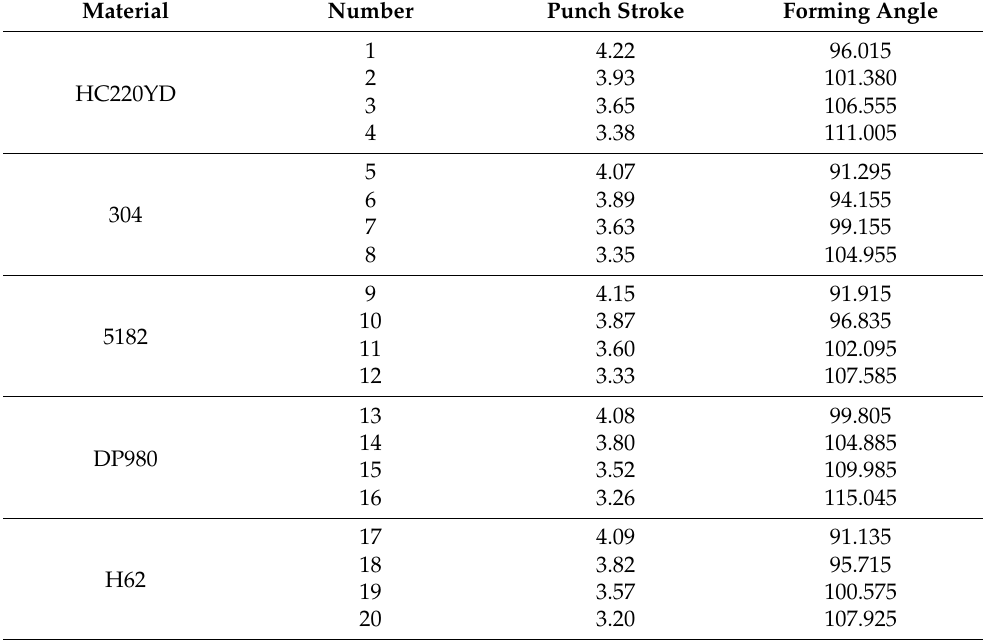
Table 5. Forming angles in bending machine experiments.